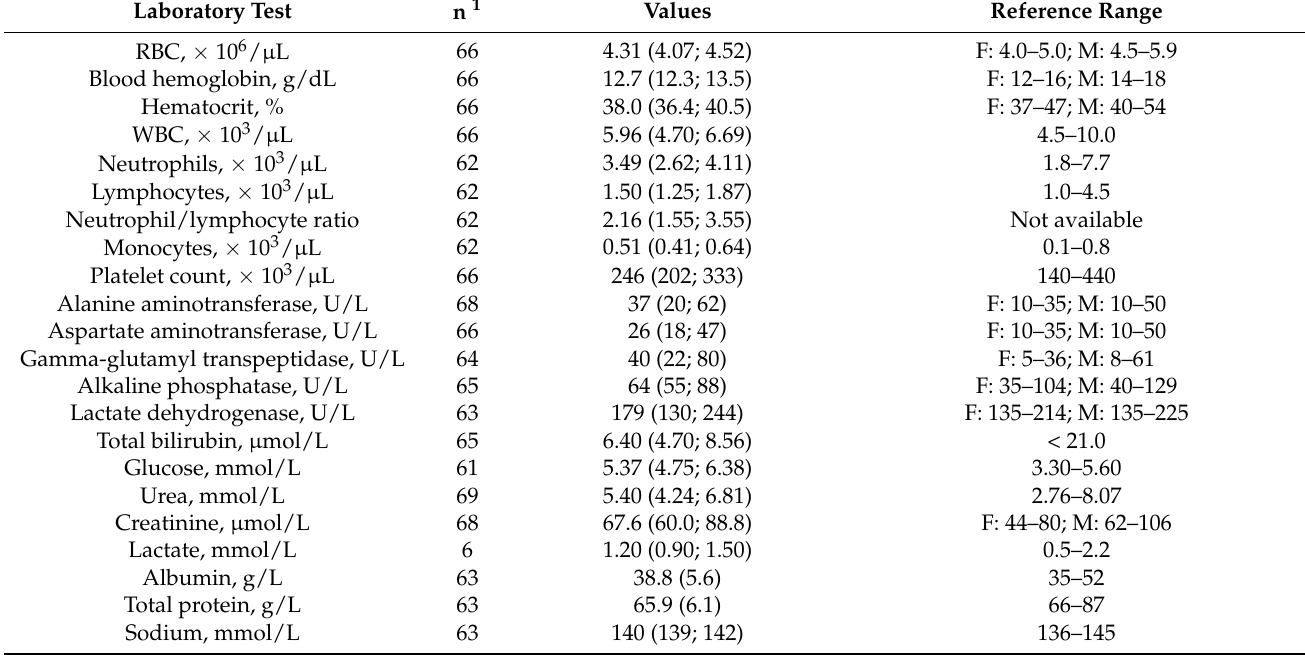
Table 2. Laboratory results. Data are shown as median (IQR) or mean